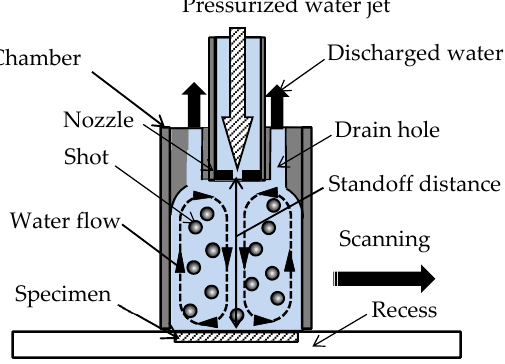
Figure 4. Schematic diagram of the peening head of the recirculating shot peening accelerated by a water jet.